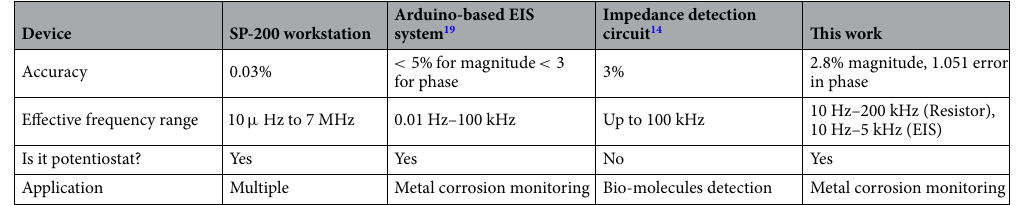
Table 4. Comparison the proposed FDICS to other